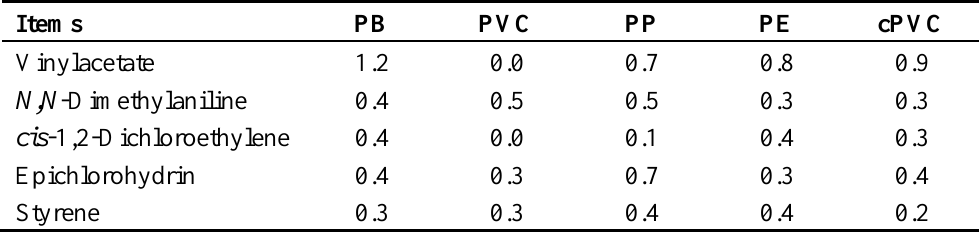
Table 4. VOC substances in plastic pipes (unit: μg / L